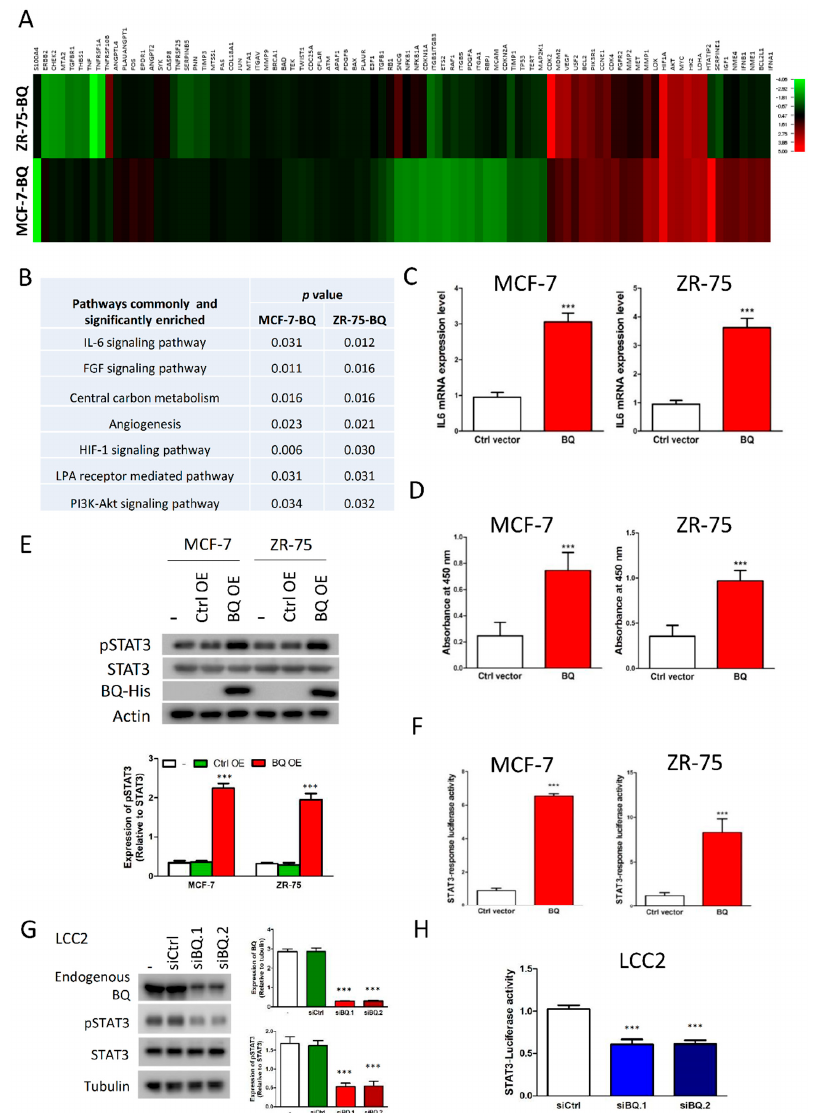
Figure 1. Overexpression of BQ could enhance IL-6/STAT3 signalling pathway in breast cancer cells. ( A ) The Heatmap showed the expression profiles of 84 cancer-related genes. The comparison was made between BQ overexpressing cells and control cells. Gene expression was compared between BQ overexpressing cells (MCF-7-BQ and ZR-75-BQ) and control cells (MCF-7 and ZR-75). Relative expression was determined and the value of expression data was subjected to log 2 transformation for plotting the Heatmap. ( B ) Signaling pathways commonly and significantly enriched ( p < 0.05) in the two BQ overexpressing breast cancer cell lines. KEGG pathway enrichment analysis was performed to identify the enriched pathways. ( C ) Overexpression of BQ could enhance mRNA expression of IL-6. MCF-7 and ZR-75 were transfected with 0.5 µg of pcDNA3.1_BQ or pcDNA3.1 . qPCR was performed 72 h post transfection. Untransfected cells were used as reference.